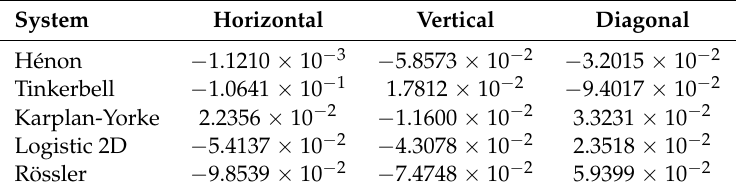
Table 7. Correlation coefficients of Lena’s cryptogram.